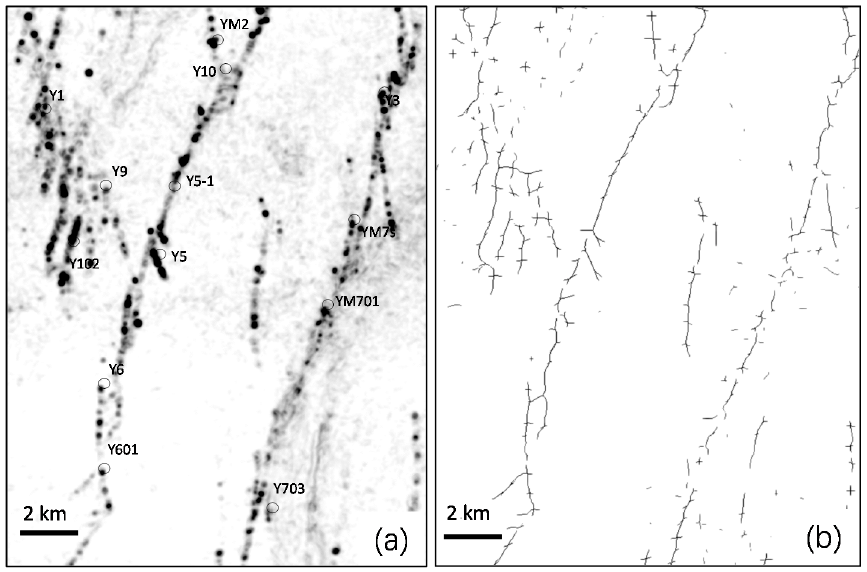
Figure 8. ( a ) Planar coherence attributeand ( b ) maximum likelihood attribute showing the strike-slip faults in a block of the Fuman Oilfield (the dark lines showing fractures).